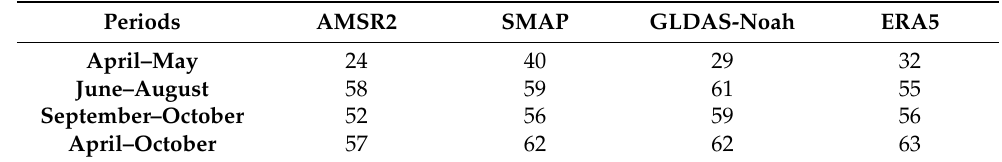
Table 3. The number of sites with positive correlation (statistically significant at 95% confidence level) between the four SM products (AMSR2, SMAP, GLDAS-Noah, and ERA5 SM) and in situ observed SM in different seasons during the non-frozen period from 2015 to 2016. Periods AMSR2 SMAP